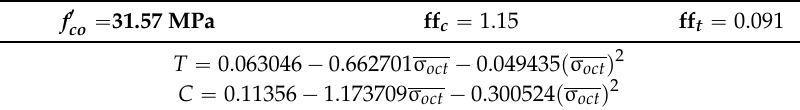
Table 4. Calibration data properties and ultimate surfaces.